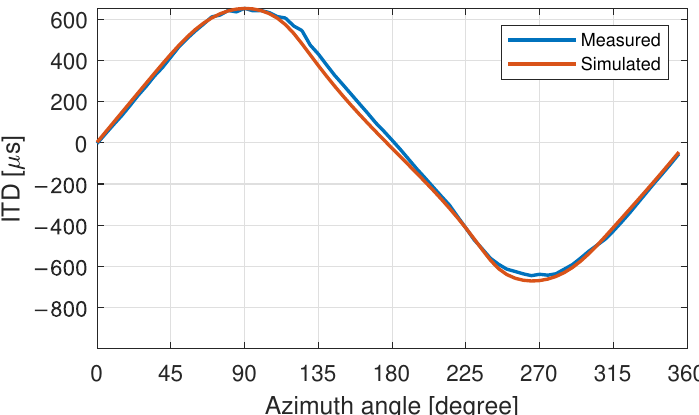
Figure 8. Comparison of measured and simulated ITD of participant 8.